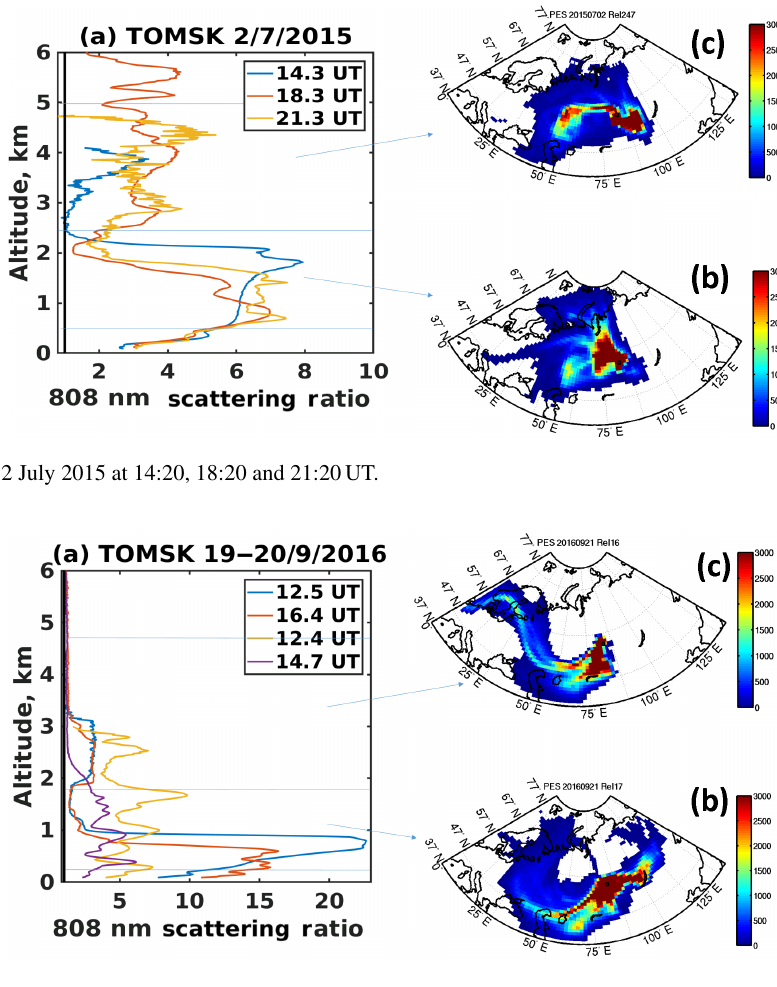
Figure 12. As Fig. 10 on 19 September 2016 at 12:30 and 16:25UT and on 20 September 2016 at 12:25 and